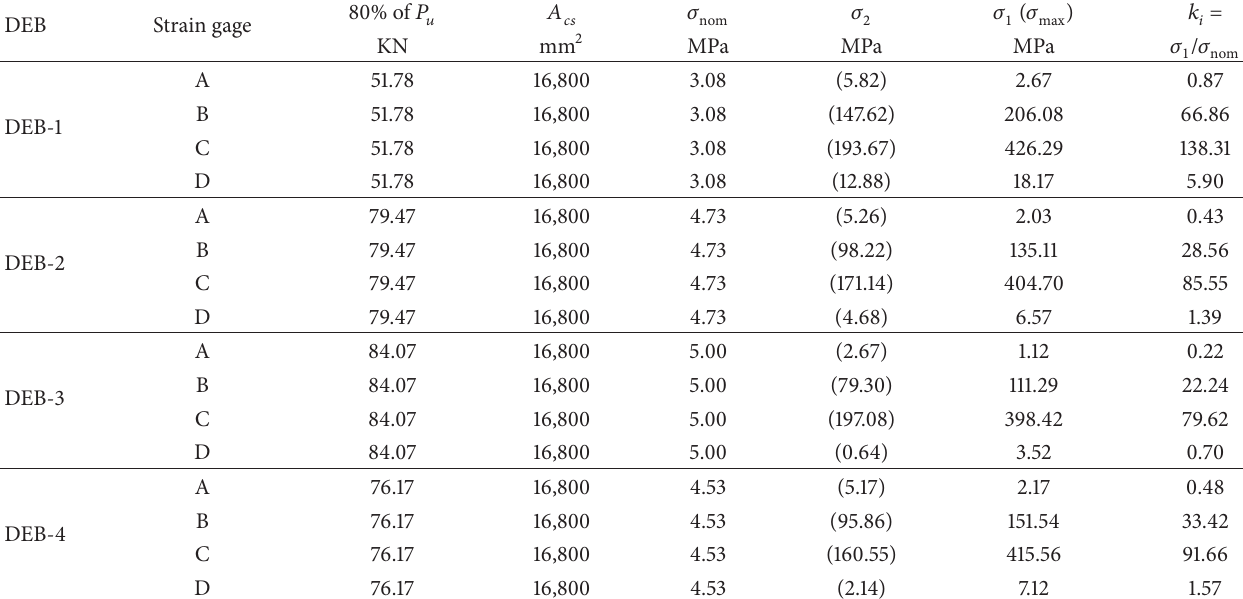
Table 4: The principal stresses and stress concentration factor at each RC-DEB (for all types of strain gages). DEB